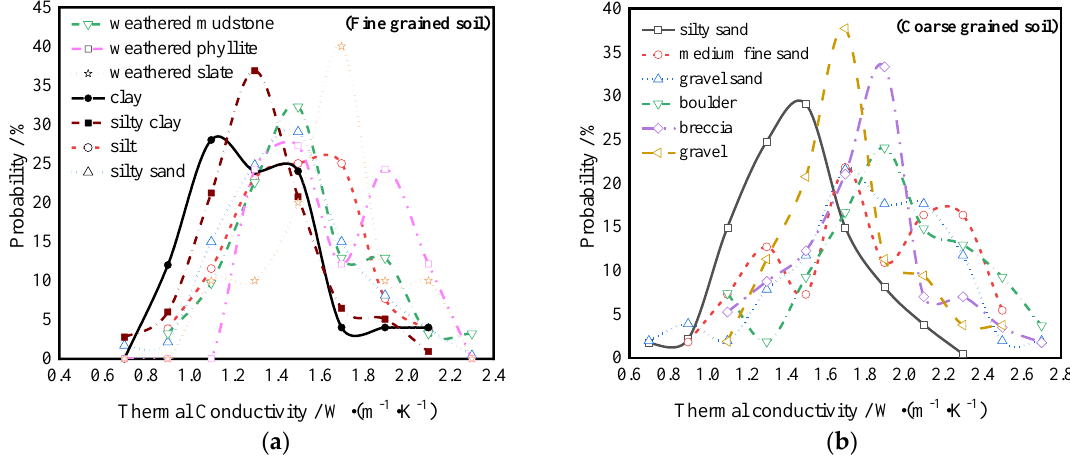
Figure 5. Probability distribution of thermal conductivity of 12 types of unfrozen soil. ( a ) Fine grained soil, ( b ) Coarse grained soil.